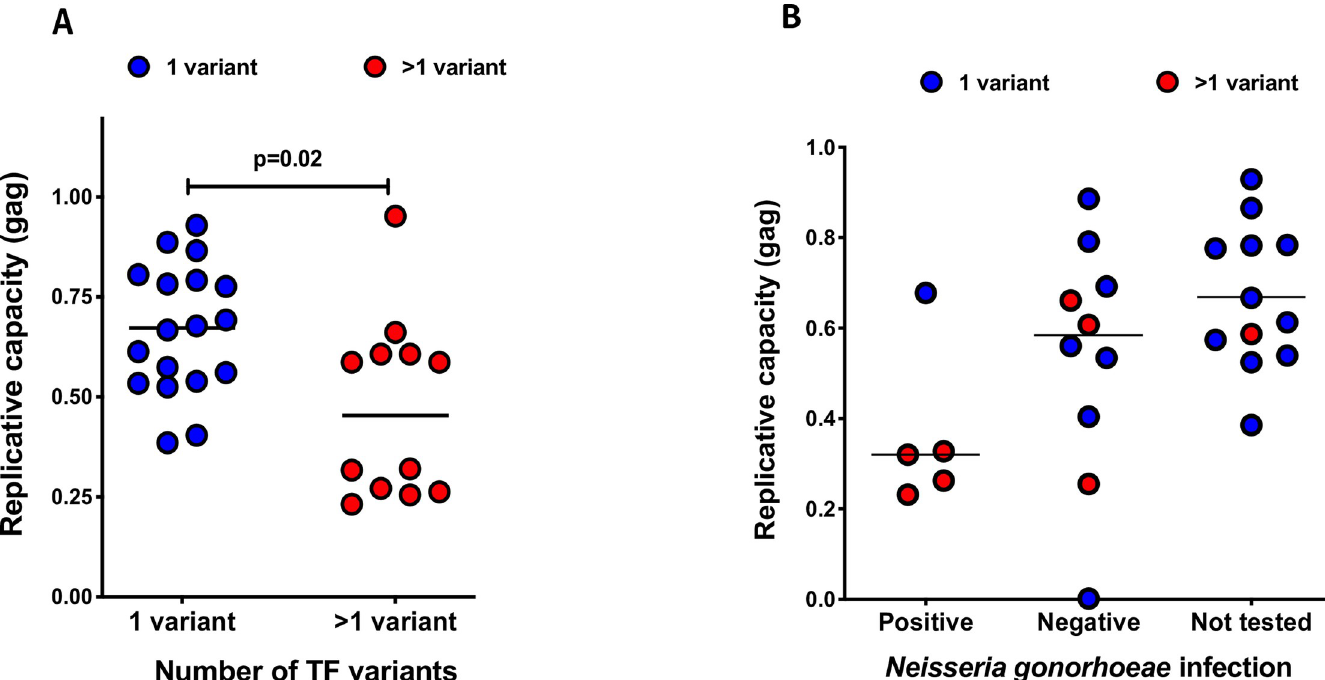
Fig 4. A) Multivariant infection was characterized by lower replicative capacity, suggesting that multiple founder variant infection resulted from a less stringent transmission selection process. Replicative capacity values in multivariant infection represent the median replicative capacity of all variant tested for each individual. B) Graphical representation of the distribution of participants who had lab confirmed Neisseria gonorrhoeae in relation to acquisition of multiple transmitted founder variants and the replicative capacity of those variants. 4 out of 5 confirmed Neisseria gonorrhoeae cases accompanied multivariant HIV infection.